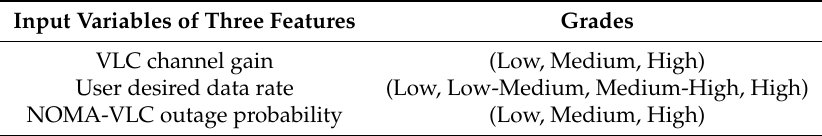
Table 1. The grades of membership fuzzification. The labels NOMA and VLC are non-orthogonal multiple access and visible light communication,